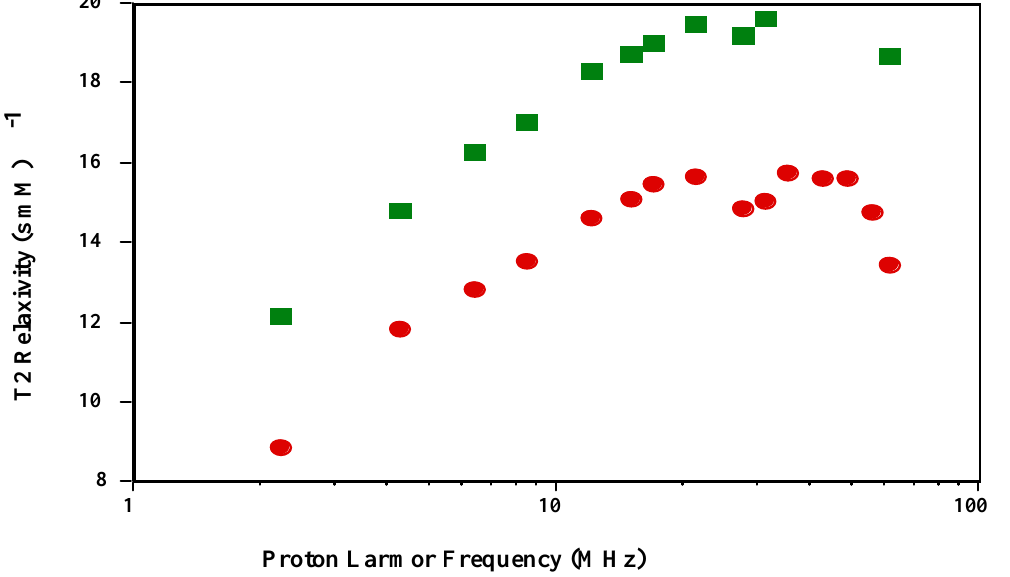
Figure 2. T2 NMRD profiles of MnT(2-C)PP and MnT(4-S)PP in PBS (pH 7.4; 23